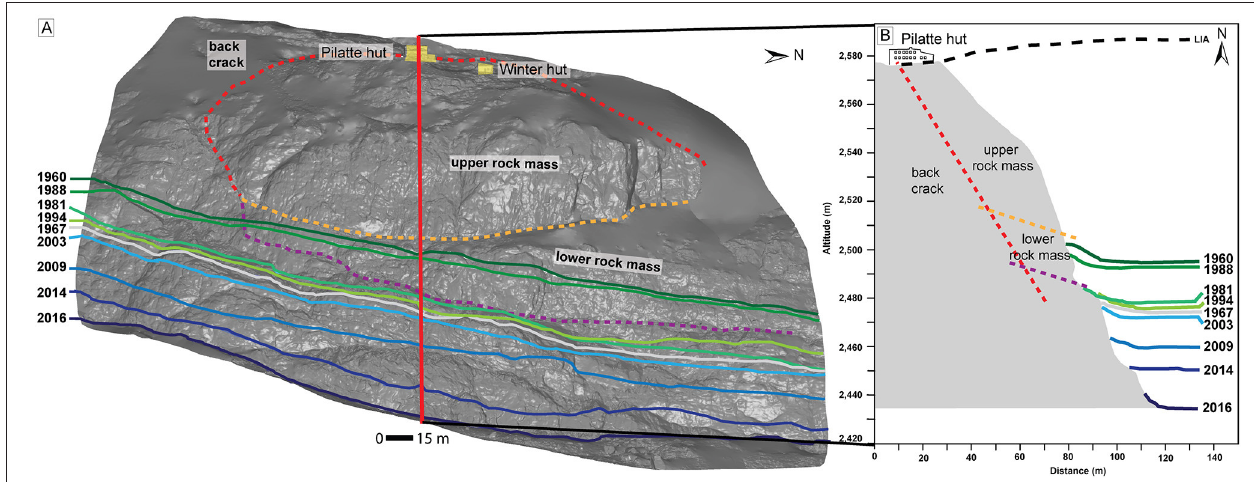
FIGURE 8 | Surface level changes of the Pilatte glacier from 1960 to 2016. These were reconstructed from SfM and TLS analysis and superimposed on the 2016 meshed point cloud. (A) View from the glacier. (B) Profile of the rock slippage zone at the foot of the Pilatte hut; sliding planes are probably inactive at the base of the upper rock mass (orange dotted line) while they are probably active at the base of the lower rock mass (purple dotted